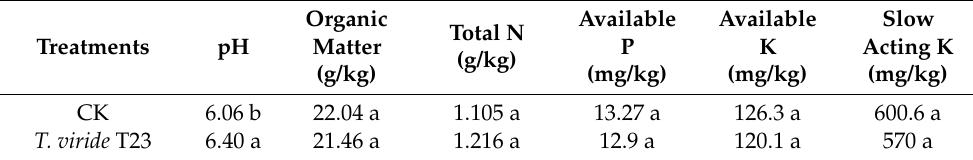
Table 2. Effects of T. viride T23 on soil physicochemical properties.